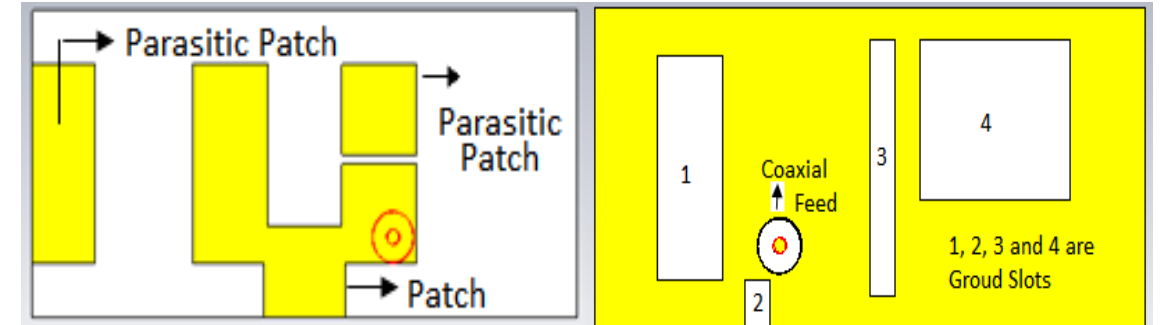
FIG. 2. PICTORIAL VIEWS OF THE PATCH AND GROUND